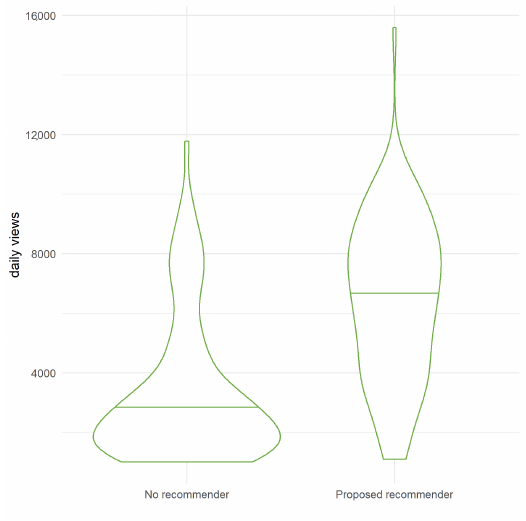
Figure 10. Video access with and without a recommender in